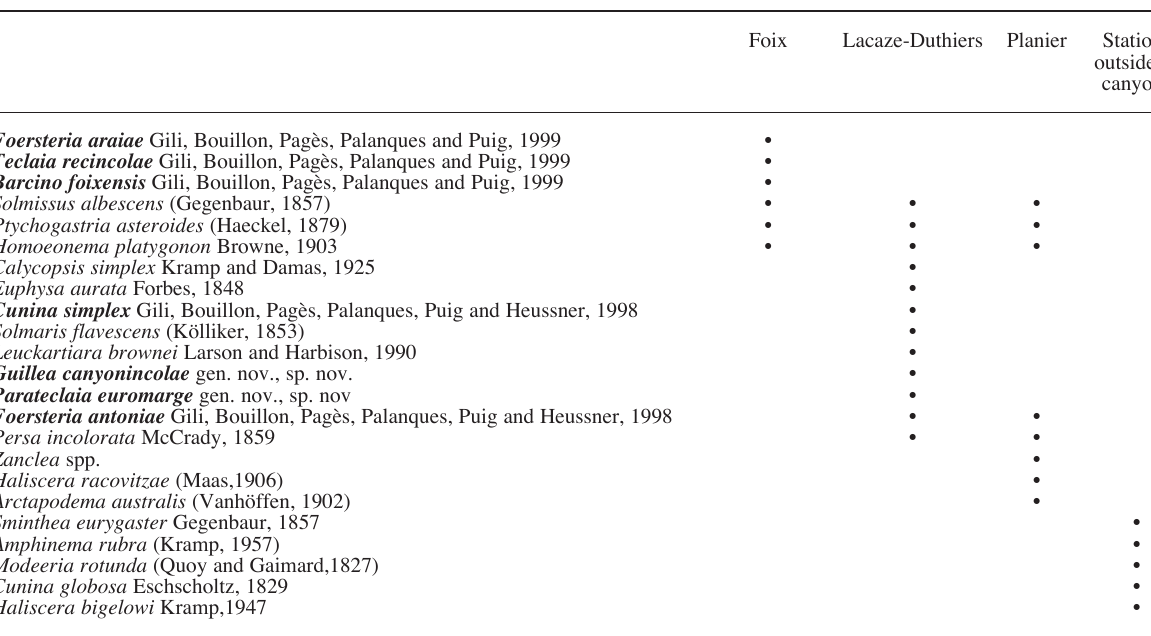
(Fig. 7a) and the opal (biogenic silica) percentage (Fig. 7b) (derived from biological activity from the surface waters on the shelf) are higher in the spring when the number of both species and individuals